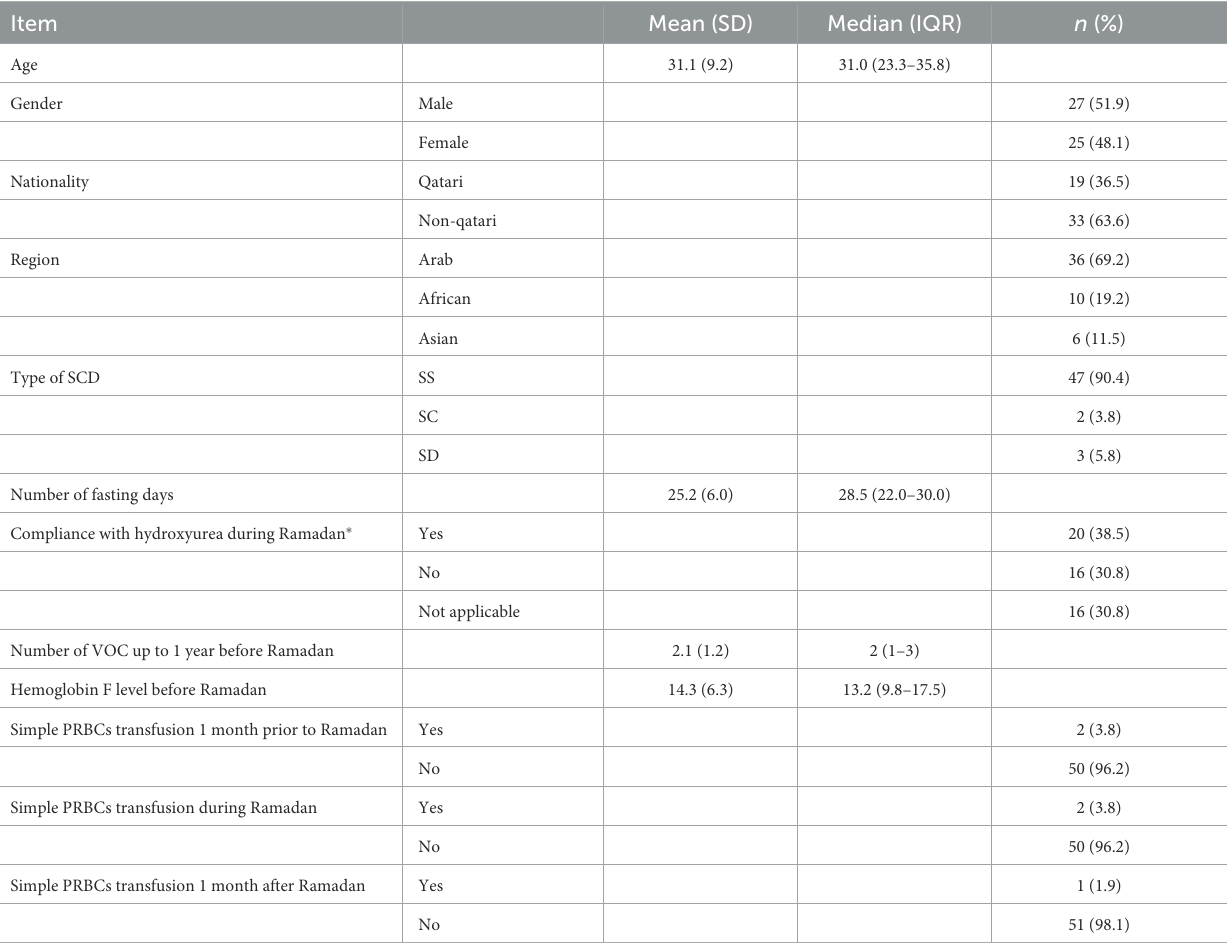
TABLE 1 Patients’ demographic, type of SCD, and fasting